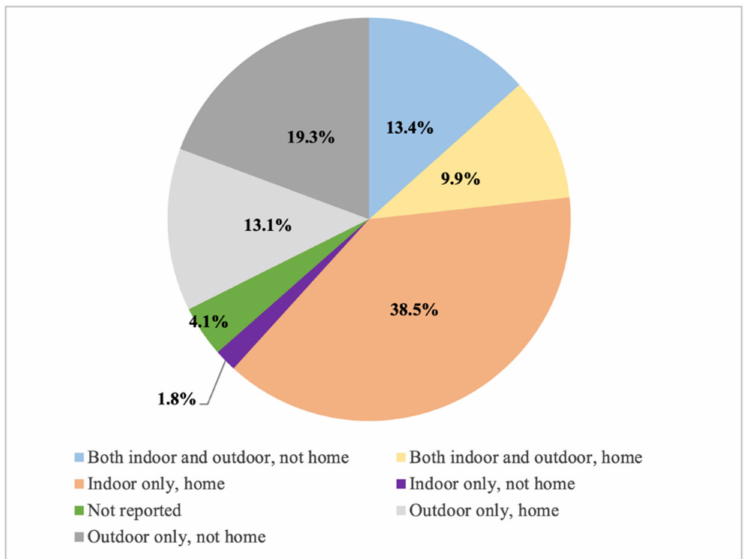
Figure 2. Location of PA among participants who reported engaging in PA during lockdown (n =